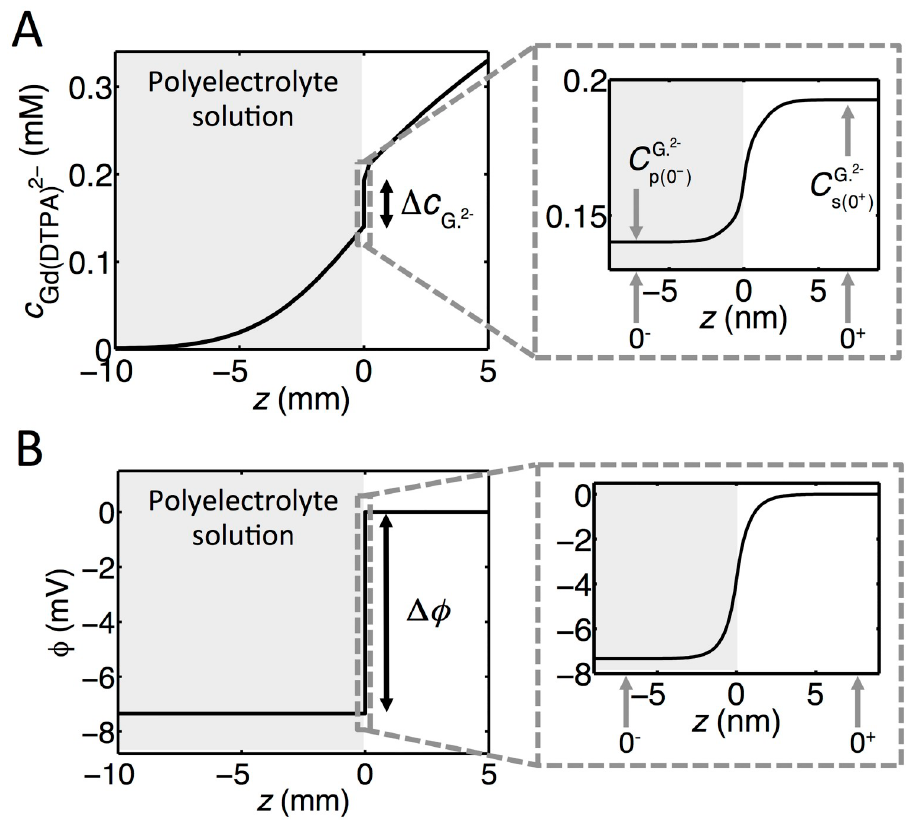
Fig 4. Concentration and potential profiles from FEM simulations. (A)A concentration profile for Gd(DTPA) 2 − 5h after addition of Gd(DTPA) 2 − in the salt solution. (B) The corresponding potential profile. The profiles are taken from FEM simulations with a polyelectrolyte solution with a FCD of -108 mM. The inserts to the right show the profiles around z = 0.